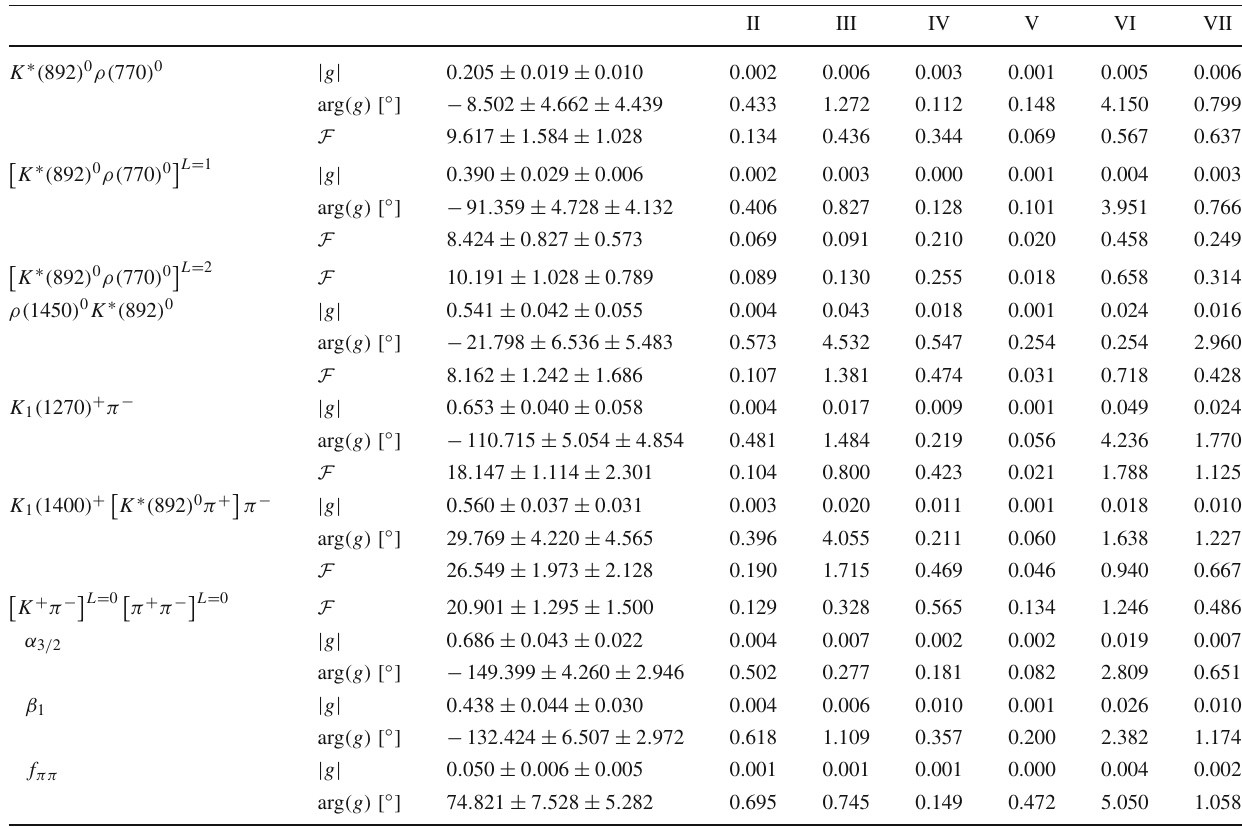
Table 16 Systematic uncertainties on the WS decay coupling parameters and fit